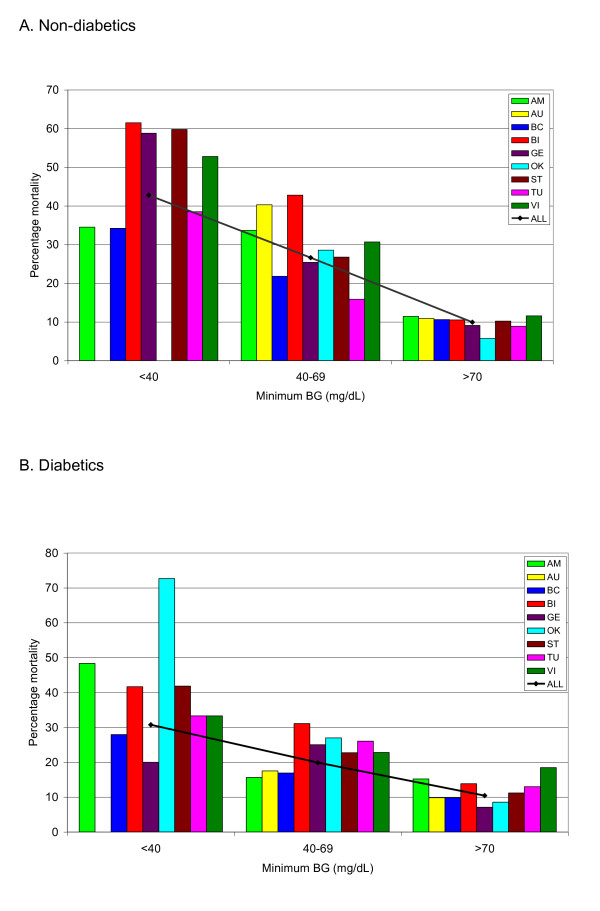
Minimum BG and mortality. The relation of minimum BG (milligrams per
deciliter) during ICU to mortality in nondiabetes (A) and diabetes
(B) patients, for each of the nine cohorts as well as the entire
population. Cohorts with fewer than 20 patients in a particular "band" are
not reported.